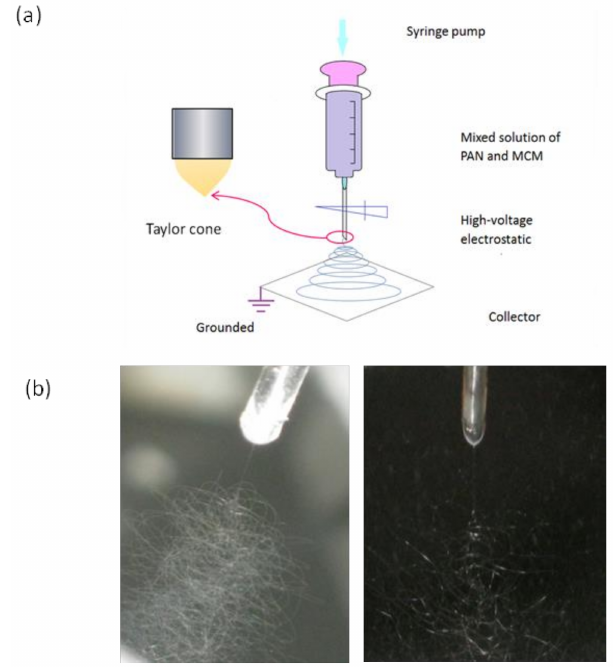
Figure 2. ( a ) A diagram of the electrospinning system; ( b ) Two typical digital images about the working processes during electrospinning.